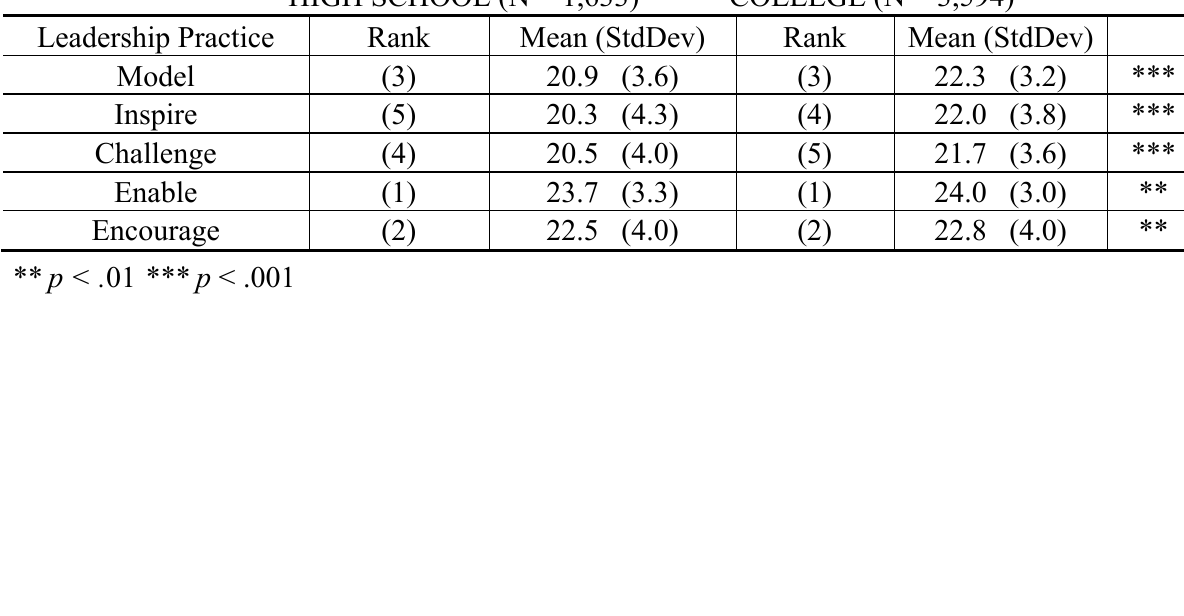
Table 6a. Comparisons between High School and College Respondents